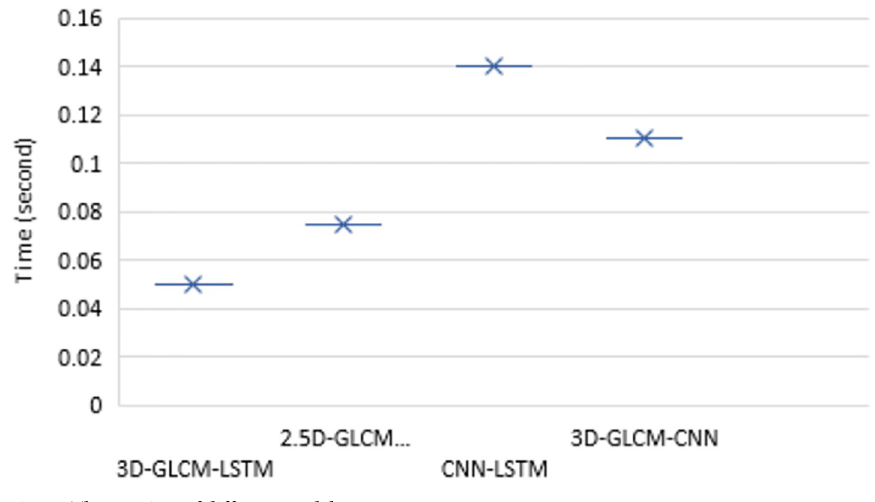
Fig 12. The test time of different